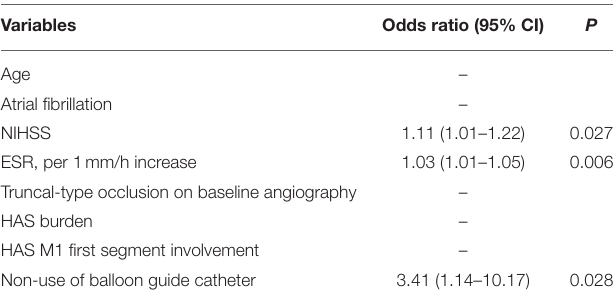
TABLE 3 | Predictors for recanalization failure.